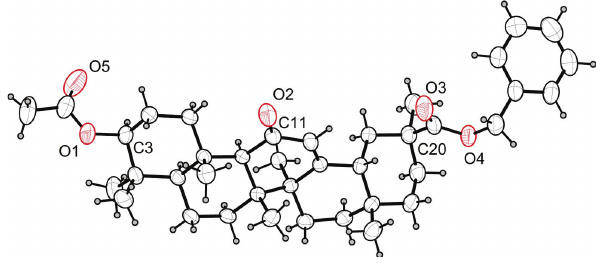
Table 1: Data collection and handling.